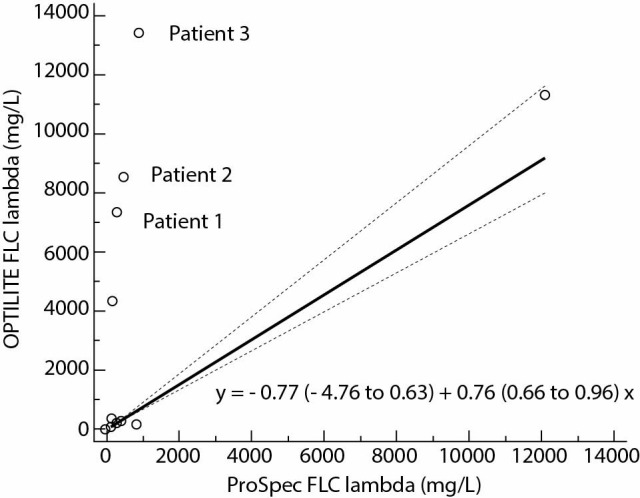
Method comparison results with 95% confidence interval (N = 37) of FLC lambda assays on ProSpec and Optilite analysers. The regression equation indicates the existence of proportional error (P = 0.460). Patients 1-3 are samples with FLC lambda values more than twelve times higher by Optilite than by ProSpec analyzer. FLC - free light chain.